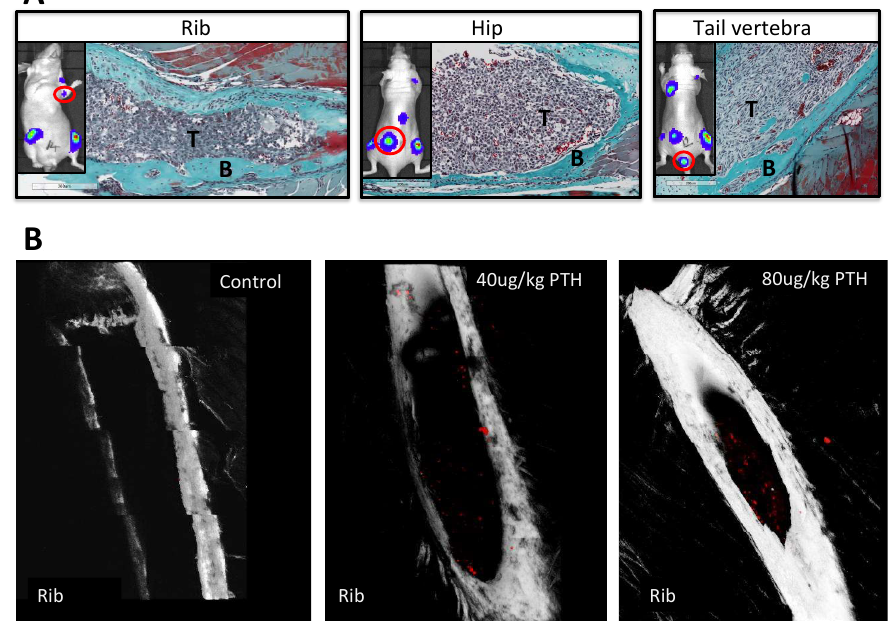
Figure 7. PTH increases tumour growth in skeletal sites outside the hind limbs. ( A ) Representative images of histological slides from tumours (indicated by T) detected in rib, hip and tail following Goldner’s trichrome staining to highlight bone (in green, indicated by B) from animals pre-treated with PTH. The inserts show the corresponding bioluminescence image for each site with the presented tumour colony highlighted by a red circle. ( B ) Example images obtained by 2-photon microscopy of ribs isolated from animals treated with PBS, 40 µ g/kg or 80 µ g/kg PTH for five days prior to injection of 0.75 × 10 5 DiD-labeled MDA-MB-231-tomato-luc2 cells. A stack area of 1262 µ m × 1683 µ m at 70 µ m depth was visualized using a 633 nm laser to detect DiD labelled tumour cells (in red).